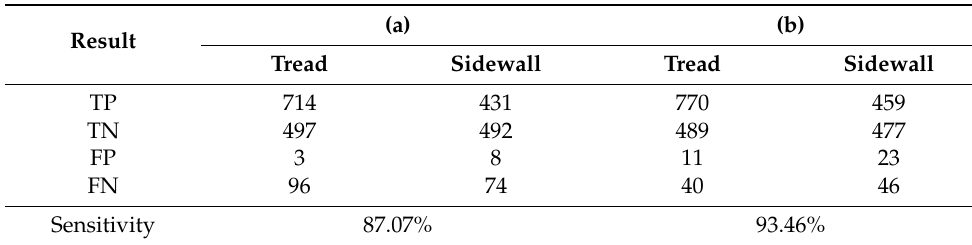
Table 5. Results Obtained by (a) the YOLOv3 SPP Architecture, (b) the Incremental YOLOv3 SPP Architecture.